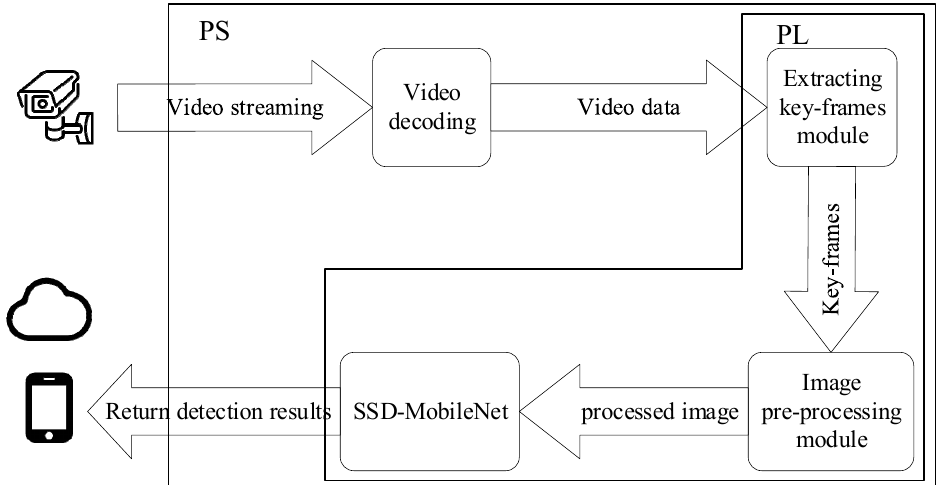
Figure 9. Video detection process.